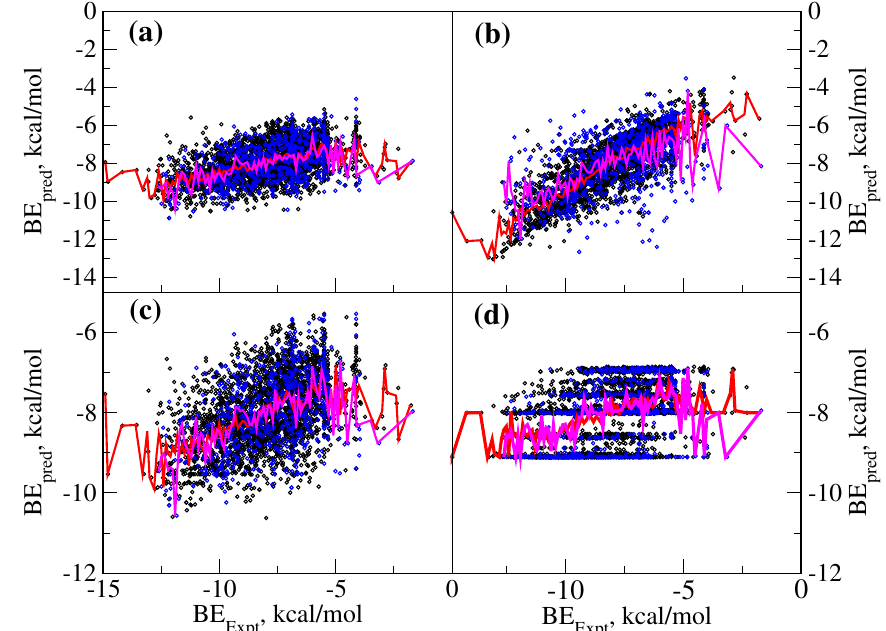
Figure 5. Comparing the experimental and machine learning-based predicted binding free energies for various MAO-B ligand complexes. The results from selected machine learning approaches: ( a ) logistic regression predictor; ( b ) k-nearest neighbor regressor; ( c ) multilinear perceptron regressor; and ( d ) random forest regressor. Black and blue dots refer to scatter diagram of experimental and predicted binding free energies and correspond to the results from training and test datasets, respectively. The plots in red and magenta color refer to F(BE expt ) as a function of experimental binding free energies computed using training and test datasets,